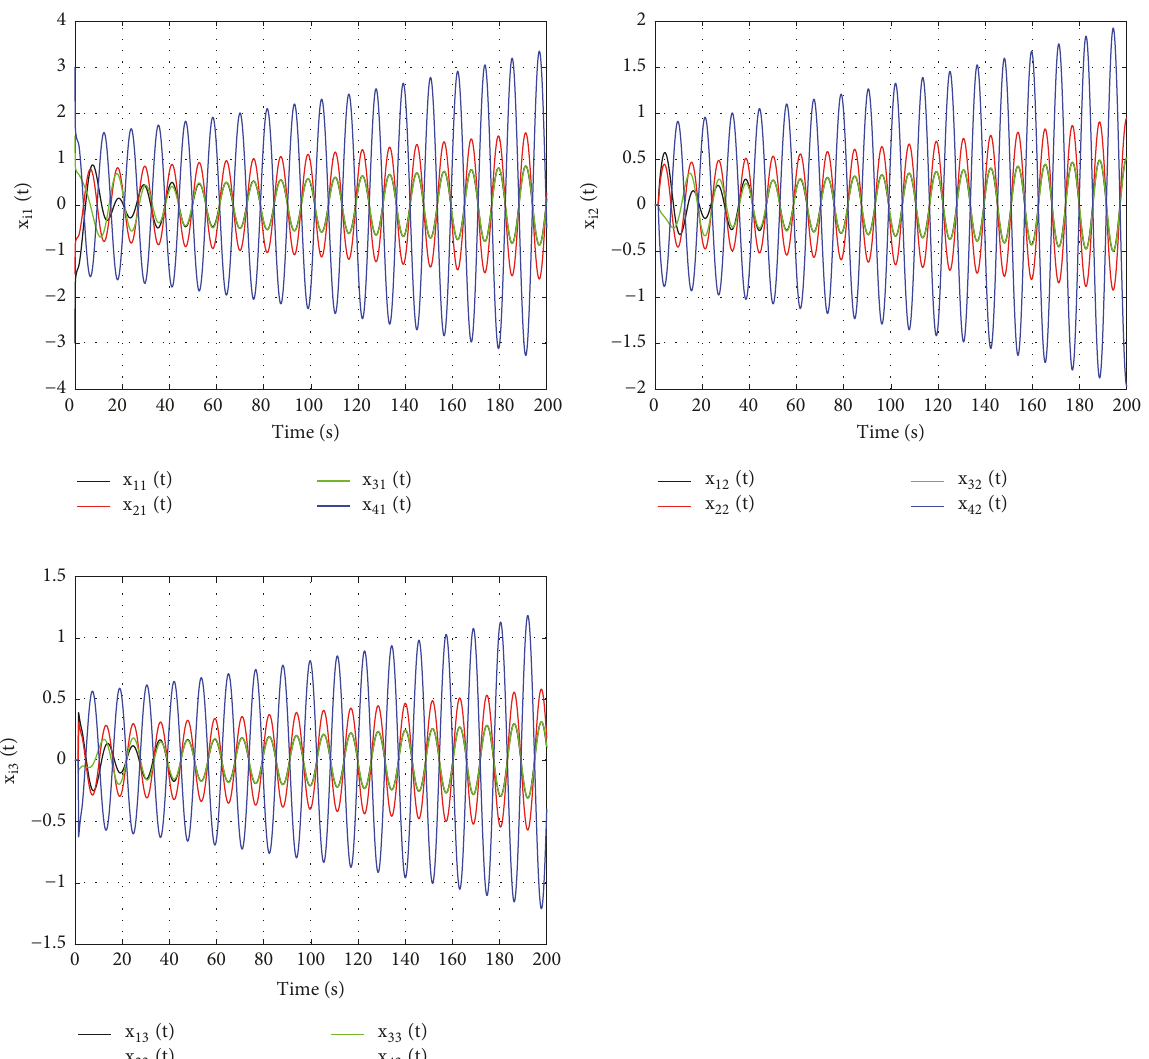
𝑃 = 2.5, 𝑃 = 9, 𝑃 = 4, 𝑃 = 8, 𝑃 = 1.2, 𝑃 = 1 ; thus 𝜏 = 2 3 4 5 6 7 0.2515𝑠 according to Theorem 4. Two groups of